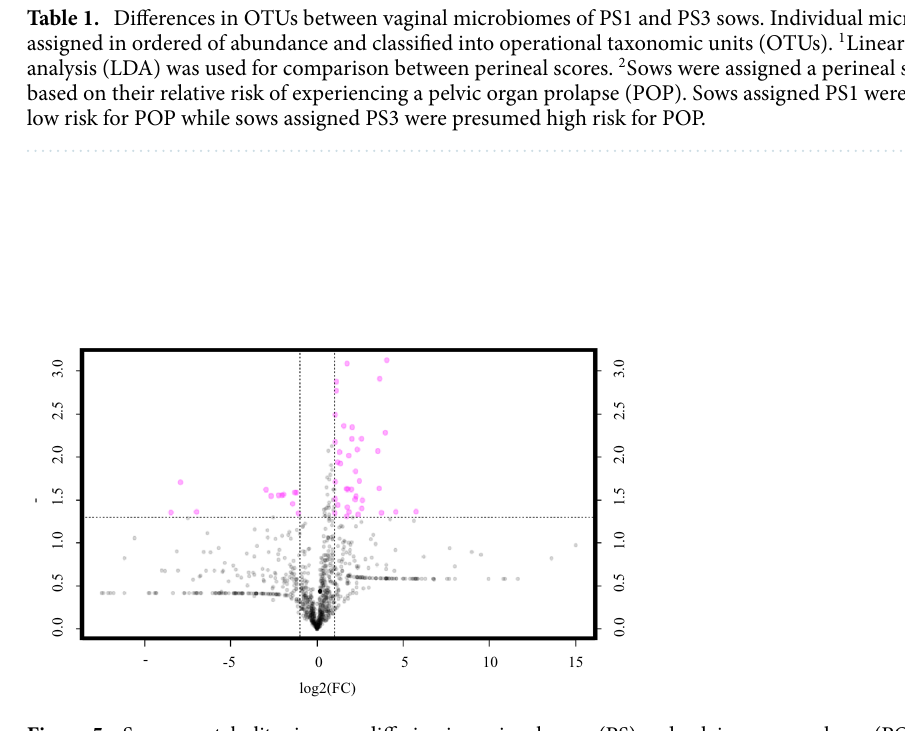
Figure 5. Serum metabolites in sows differing in perineal score (PS) and pelvic organ prolapse (POP) risk. This plot represents important features and demonstrates those which are different between sows with a PS3 (high risk for POP) compared to PS1 (low risk for POP). The pink circles represent features above the threshold (twofold change and P < 0.05). PS1 averages were set as the base level and PS3 values of individual metabolites are represented by points. The pink dots represent the individual metabolites that are considered significantly different between PS. Pink dots in the upper right are metabolites that are more abundant, on average, in PS3 animals, and pink dots in the upper left less abundant, on average, in PS3 animals. Note both fold changes and P -values are log transformed. The further the position from the (0,0), the greater level of statistical significance for that the